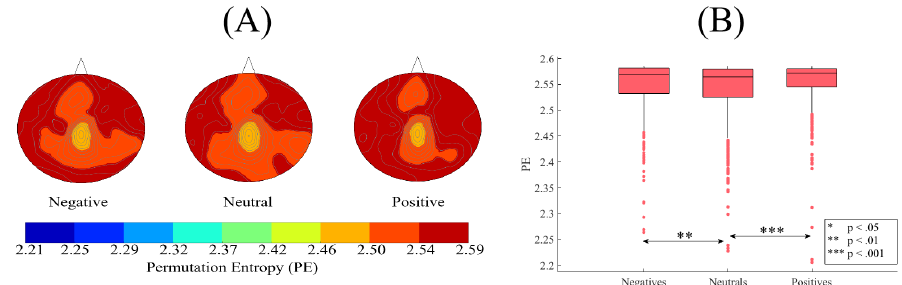
Figure 3. ( A ) Grand averages of the spatial maps of participants’ PEs in negative, neutral, and positive affect